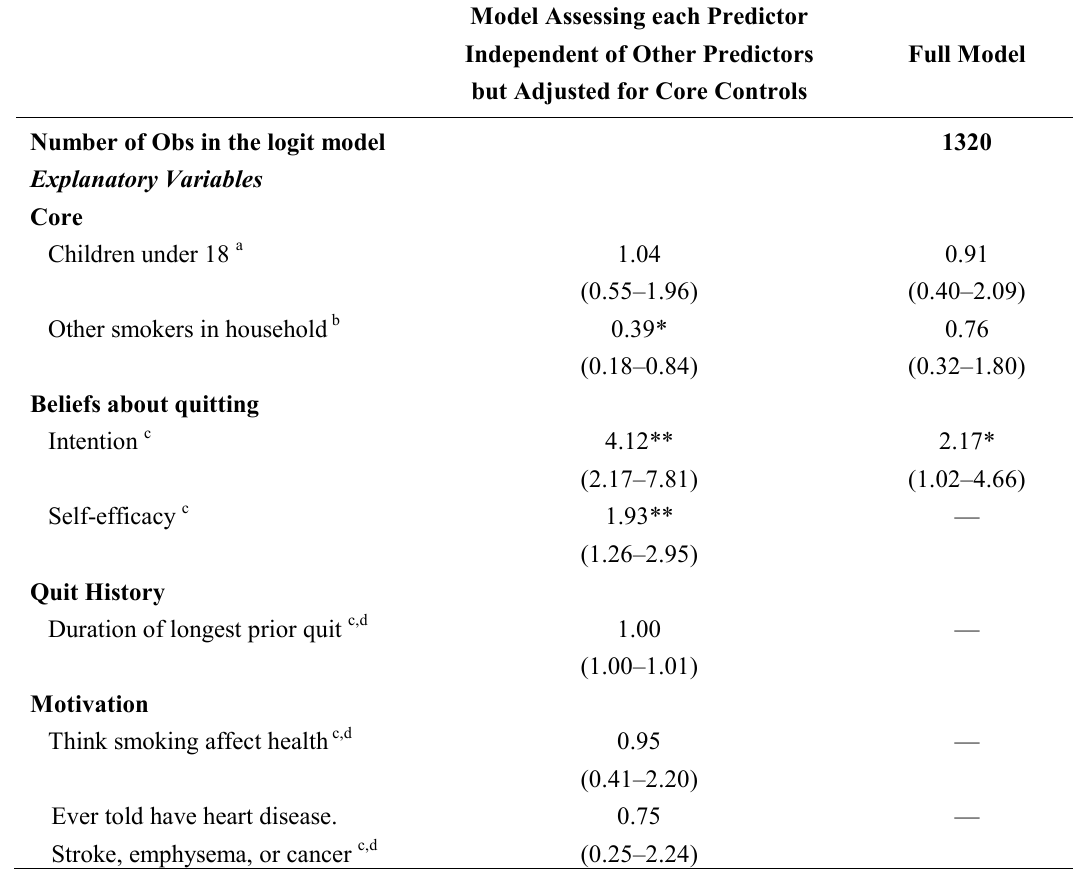
Table 3. Predictors for maintaining successful quit